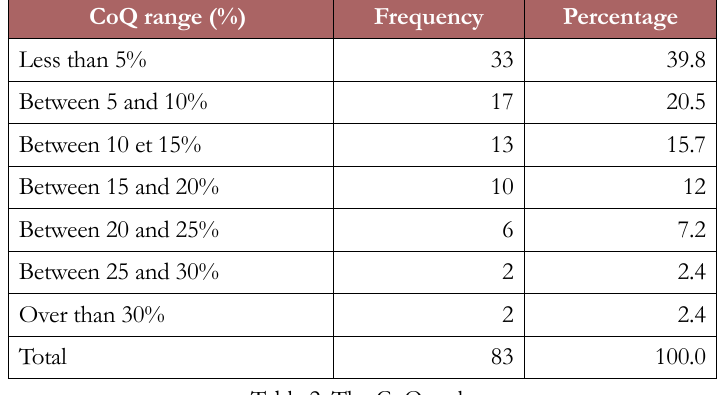
Table 2. The CoQ scale